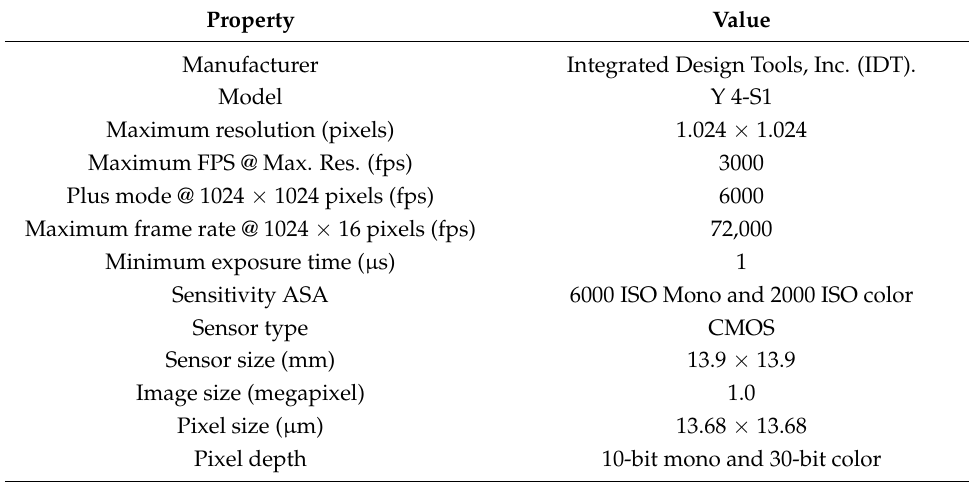
Table 3. Specifications of high-speed camera.